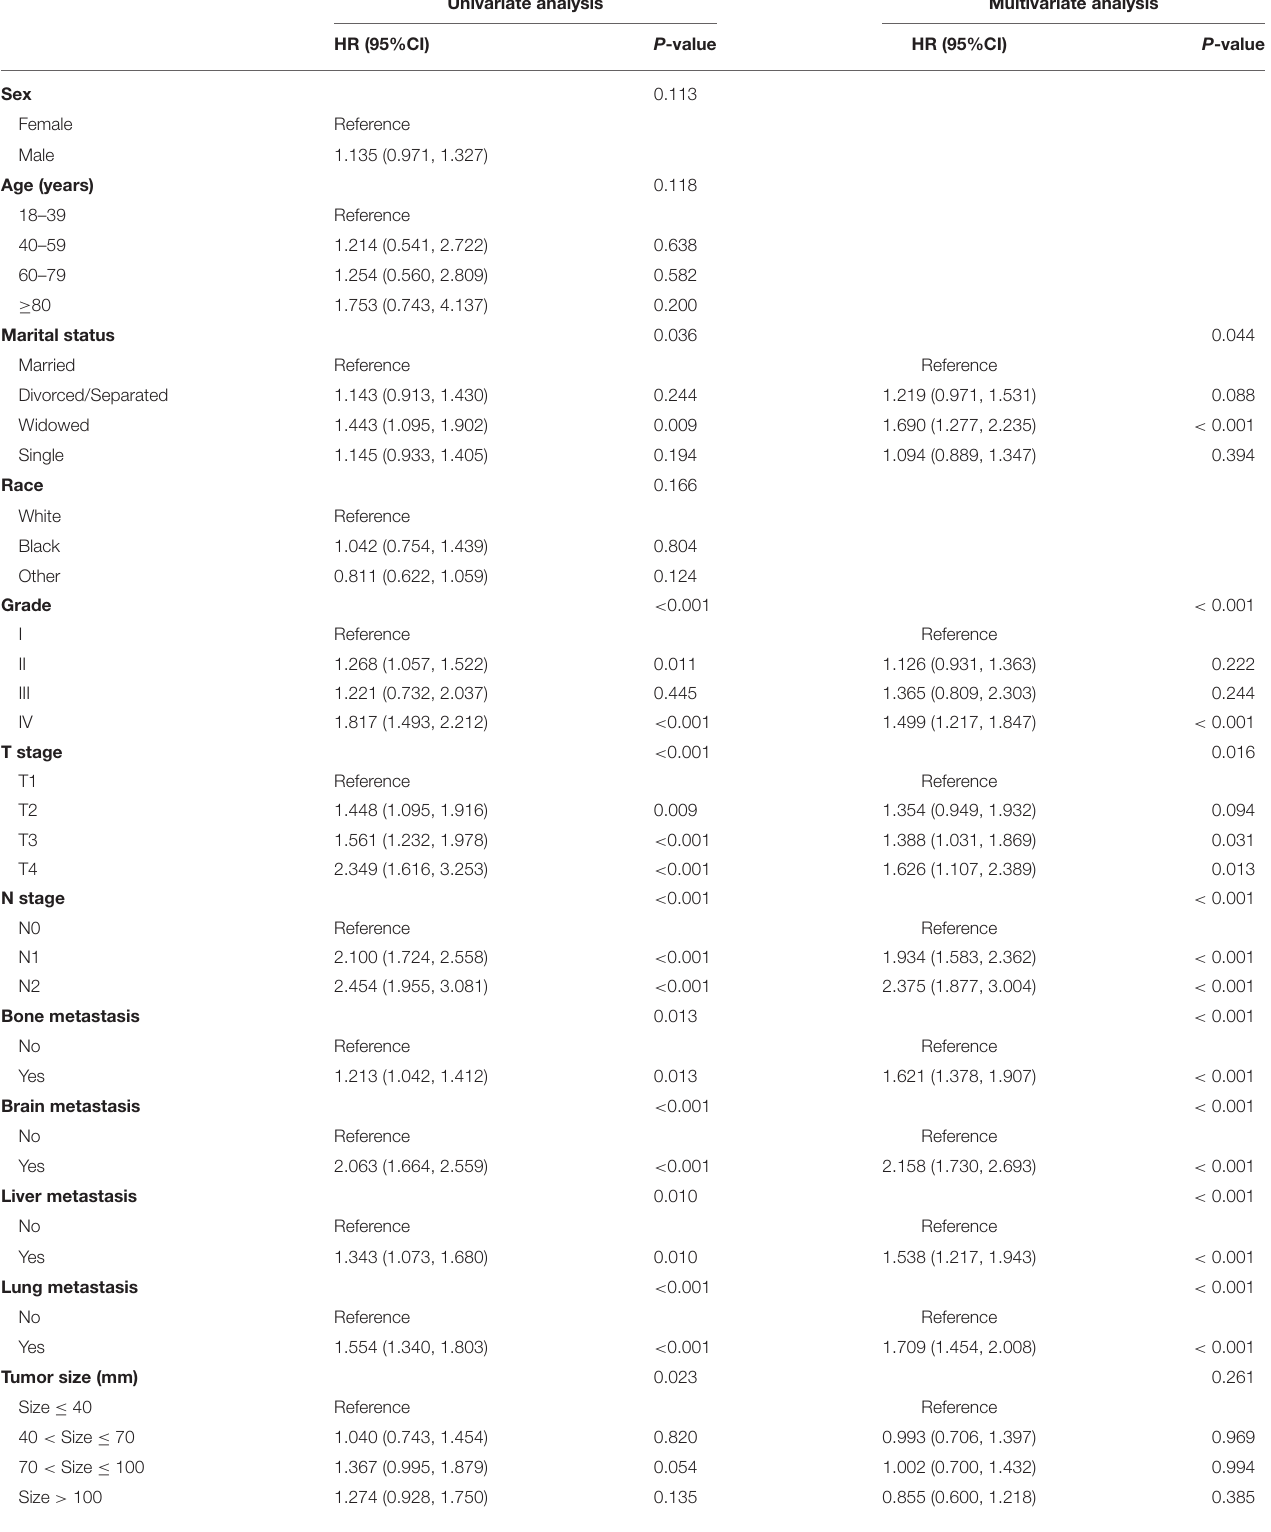
TABLE 2 | Univariate and multivariate Cox analyses of overall survival in the training set. Univariate analysis Multivariate